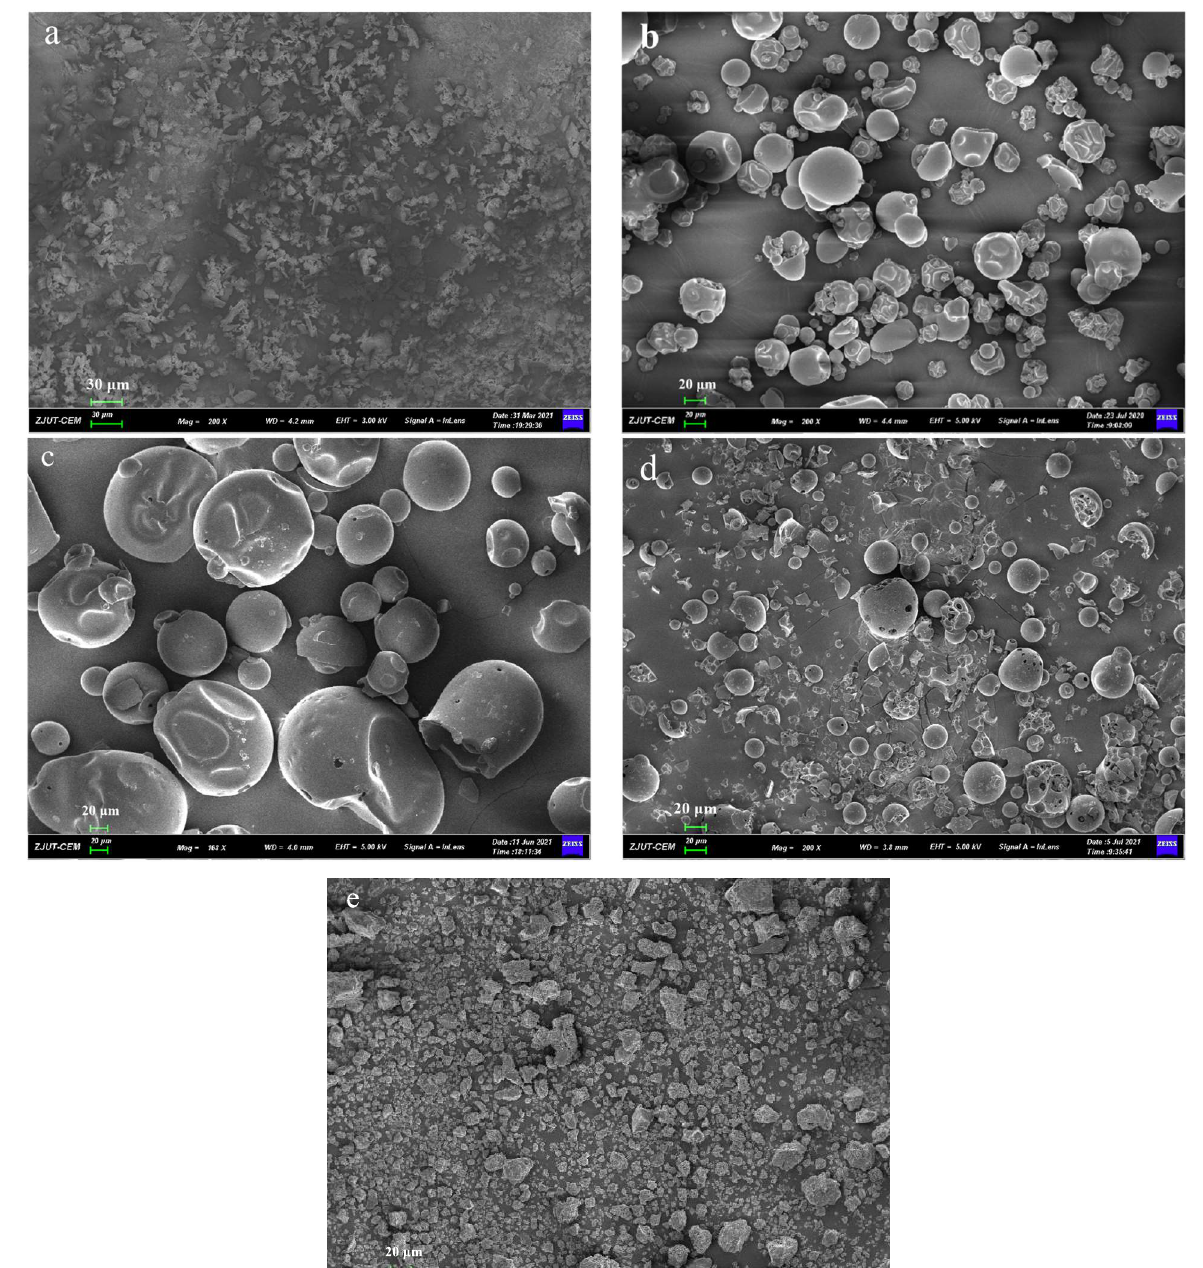
10 of 23 Figure 4. FT-IR spectra of ( a ) DNC, ( b ) GA, ( c ) PVP K30, ( d ) DNC/GA/PVP K30 SD, and ( e ) DNC/GA/PVP K30 SD. 3.4. SEM